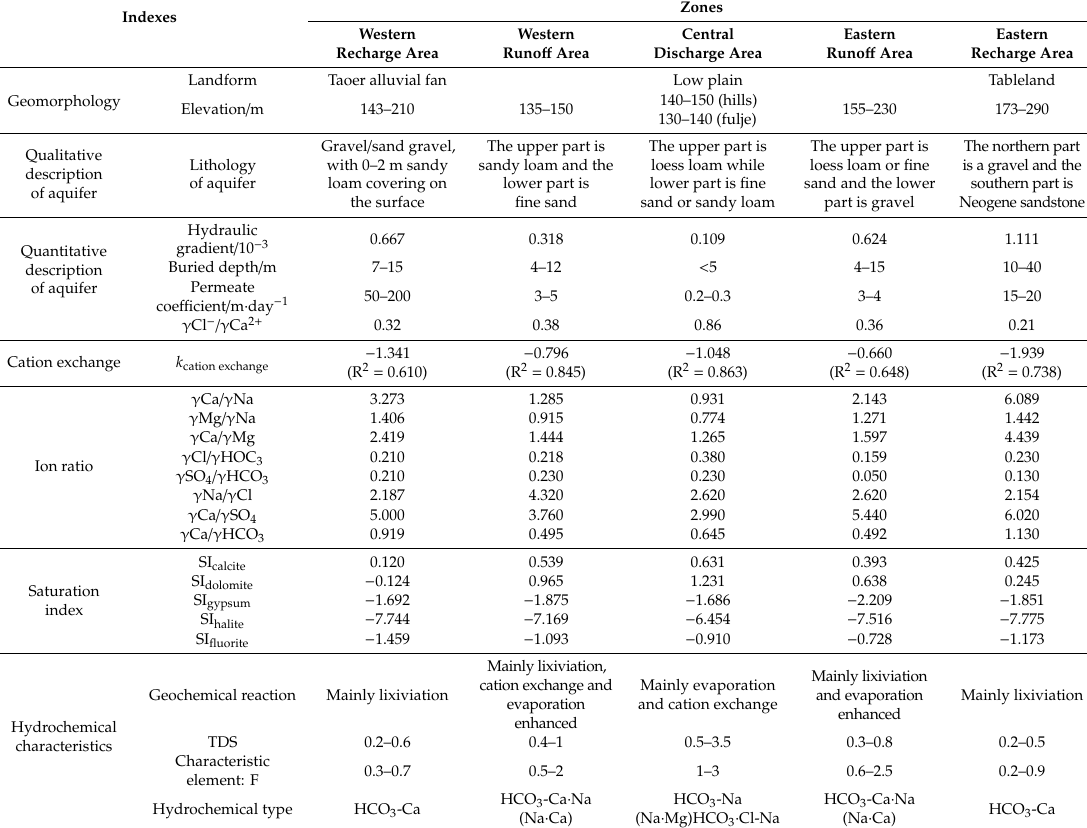
Table 3. Qualitative and quantitative indexes of hydrogeochemical zonation. Indexes